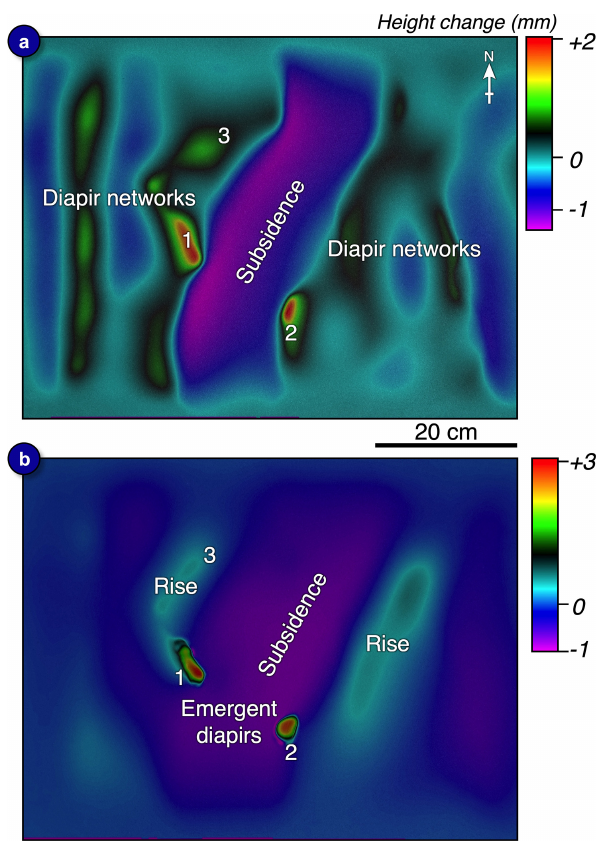
Figure 6. Height-change maps of Model 1 after 16h (a) and 48h (b) of post-extension loading. In (a) we see the major diapir networks, formed during extension, continuing to rise as salt is expelled from beneath adjacent minibasins. After 48h (b) , loading activity is now focused on two major diapirs. See main text for more